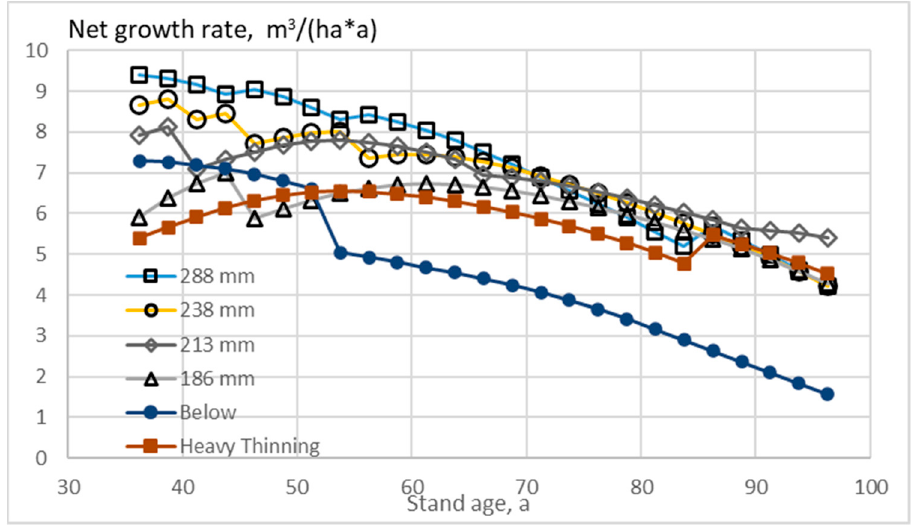
Figure 8. Net annual growth rate per hectare for six different treatments applied on a normal stand representing the example estate. The growth rate is computed for any 30-month period, without integration over the site lifespan.